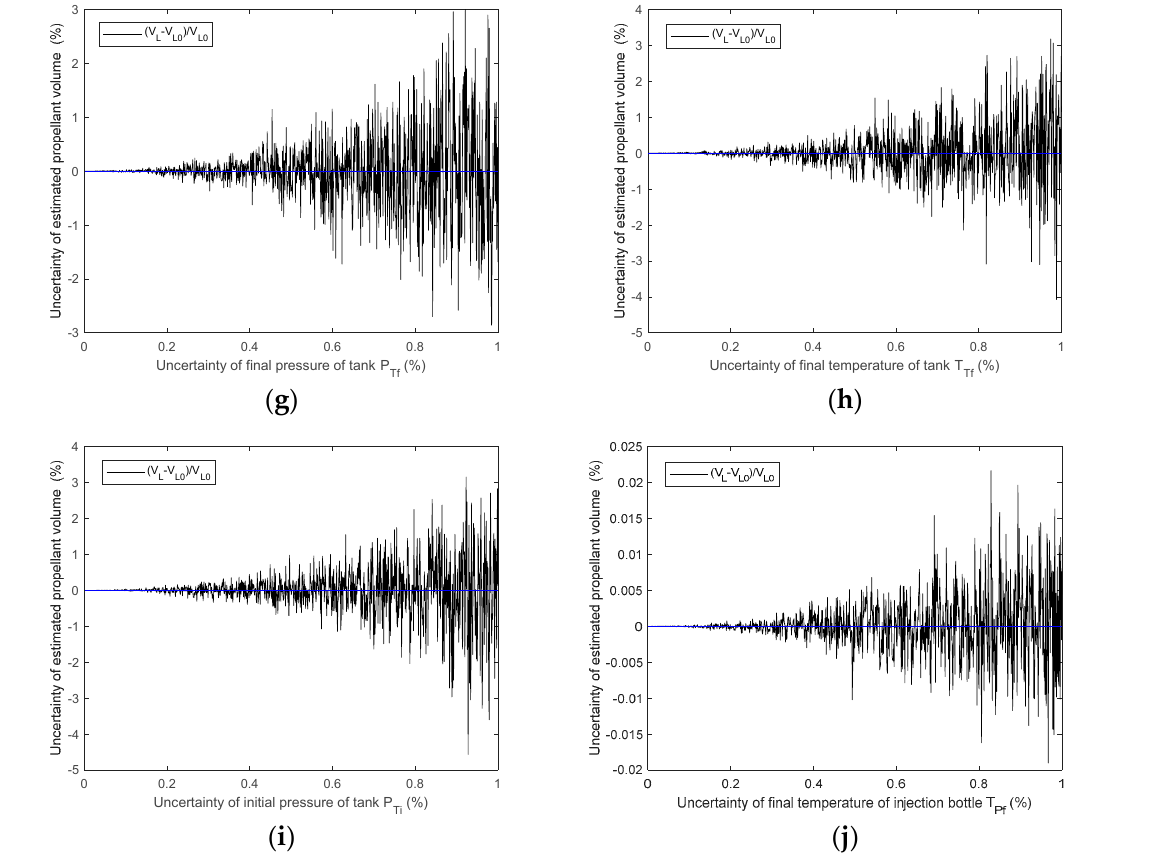
Figure 2. Effect of each factor on the final mass gauge uncertainty (( a ) is of the total volume of the tank, ( b ) is of the injection bottle volume, ( c ) is of the initial pressure of the injection bottle, ( d ) is of the initial temperature of the injection bottle, ( e ) is of the final pressure of the injection bottle, ( f ) is of the final temperature of the injection bottle, ( g ) is of the final pressure of the tank, ( h ) is of the final temperature of the tank, ( i ) is of the initial pressure of the tank, and ( j ) is of the final tenperature of the injection bottle).